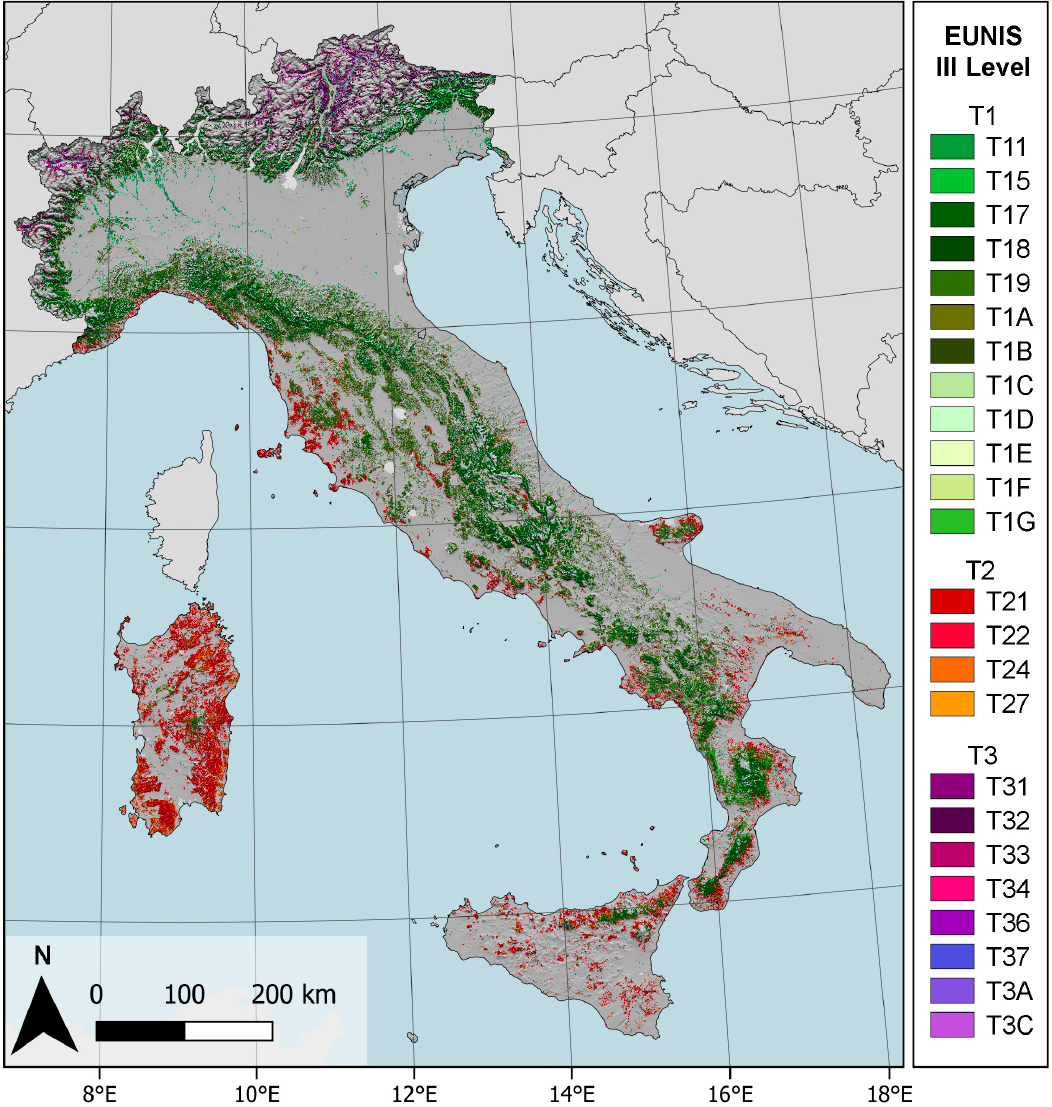
Figure 5. Forest habitat map of Italy from RF at EUNIS III level classification. The color legend format follows Pedrotti 2012 [102]. For the code reference of the legend, see Table 3.